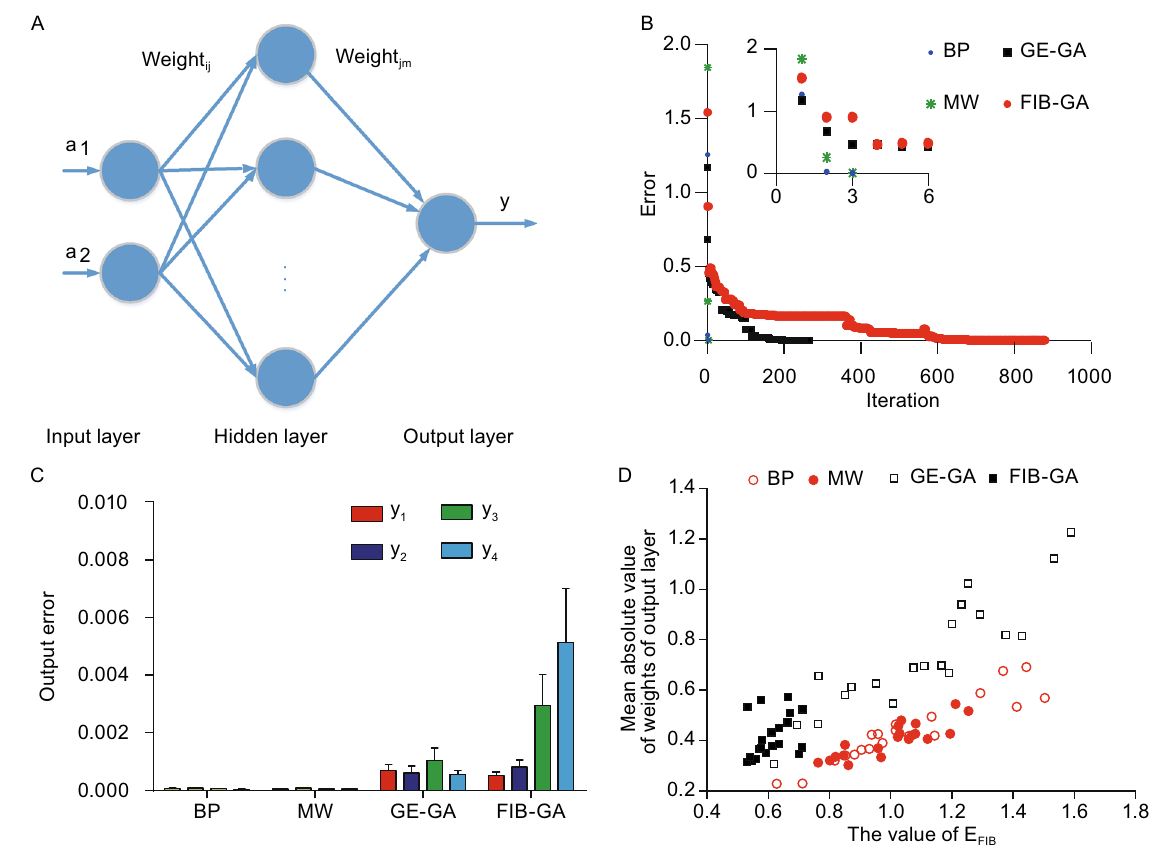
Figure 1. The use of BP, MW, GE-GA, and FIB-GA in training ANNs to solve an XOR problem. (A) The topology of the arti fi cial neural networks. (B) The plot of the fi tting errors versus the number of iterations. The inset shows the changes of the error within the initial six iterations. (C) The summary graph comparing the error of each element in the output vectors between BP ANN, MW ANN, GE-GA ANN, and FIB-GA ANN. (D) The plot of the weights for the output neuron versus the fi tting errors in ANN training with the BP, MW, GE-GA, and FIB-GA.